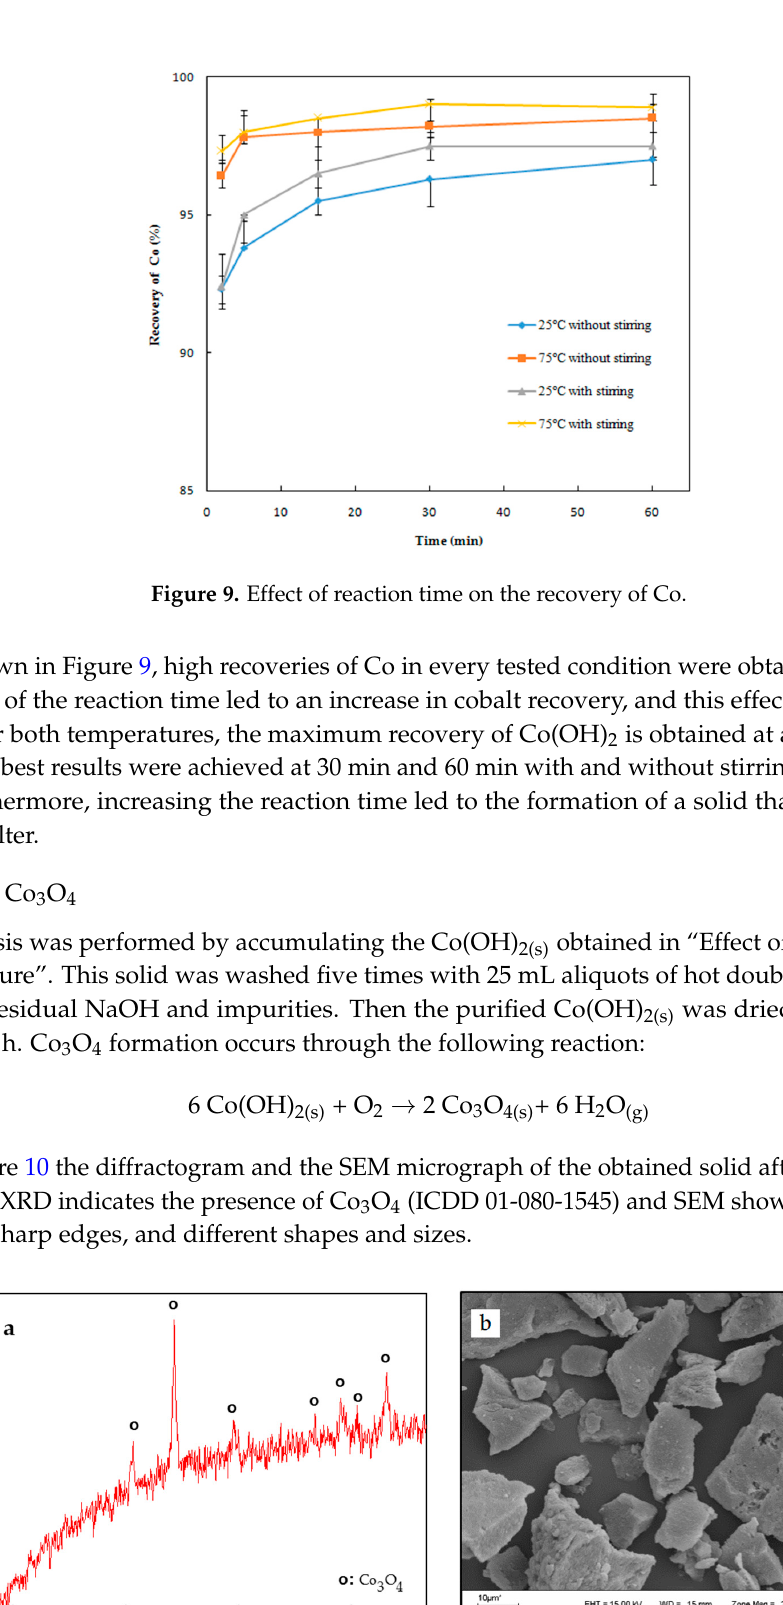
Figure 10. ( a ) XRD and ( b ) SEM of the precipitated solid by the addition of NaOH.